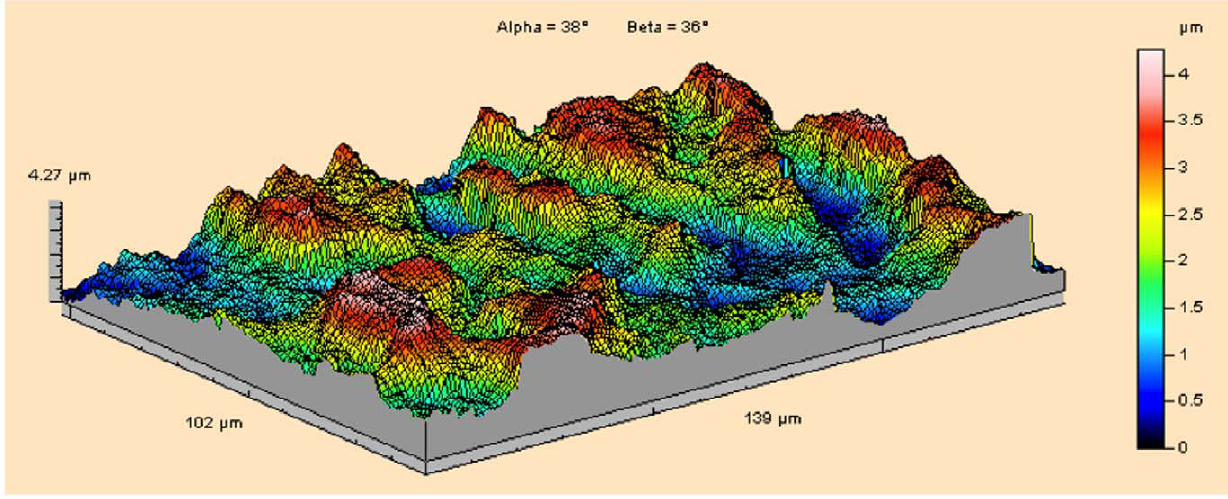
Figure 4. Enamel surface of the P 4 of a Cercocebusatys specimen collected from Taı ¨ Forest, Co ˆ te d’Ivoire. The topography of wear resembles that of other primate hard-object feeders (e.g., some Cebus apella and Lophocebus albigena ). (Table 4). Among living primates, relative enamel thickness is greater in hard-object feeders [50–52], although thick molar enamel is not prerequisite to durophagy [47].